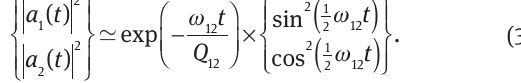
Figure 4: Magnetic and electric dipole resonance anticrossing. Anti-crossing behavior of the observed peak splitting as a function of the bare Mie-exciton detuning for the magnetic dipole (A) and the electric dipole (B) resonances. Red lines show the fitting based on a two coupled oscillators model, with only the coupling strength g as a fitting parameter. The fitting result is indicated in the